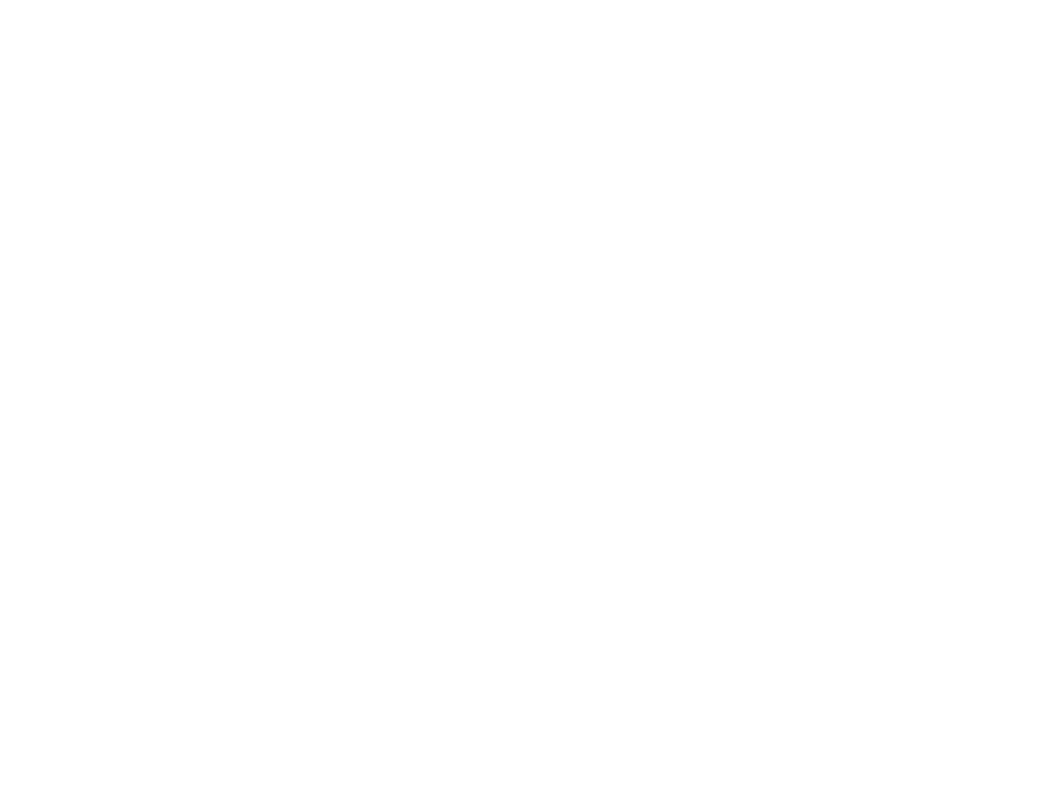
FIGURE 7 | Cs + /H + antiport activity of everted membrane vesicle from strain KNabc/pBAD-00475 at pH 8.0, 8.5, and 9.0. The Cs + /H + antiport activity of everted membrane vesicles from strain KNabc/pBAD-00475 in each pH buffer was shown when various concentrations of Cs 2 SO 4 were added. The details are described in the Materials and Methods section. The vertical axis shows antiport activity (%Dequenching), and the horizontal axis shows the Cs + concentration. Error bars show the standard deviation of three independent experiments. In addition, each Lineweaver-Burk plot diagram is